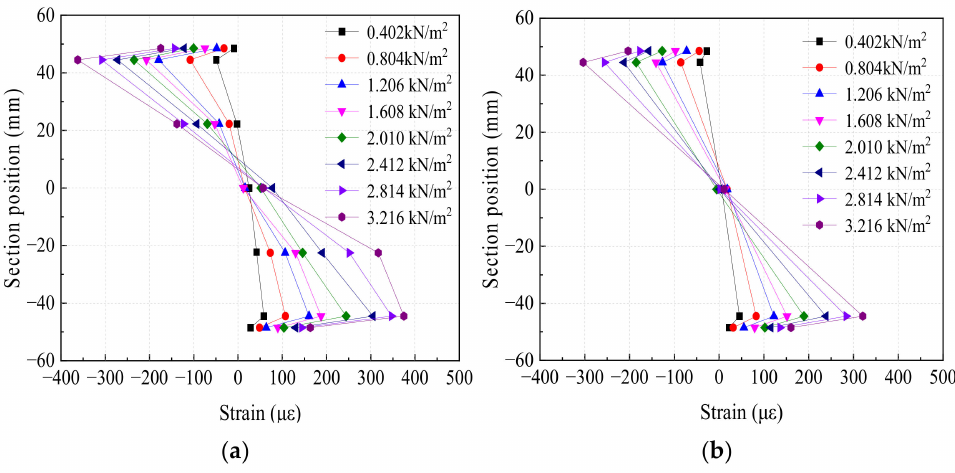
Figure 15. Strain distribution curves of mid-span section. ( a ) QB1-I-L-2.5-5-1 ( b ) QB5-II-L-2.5-3-1.